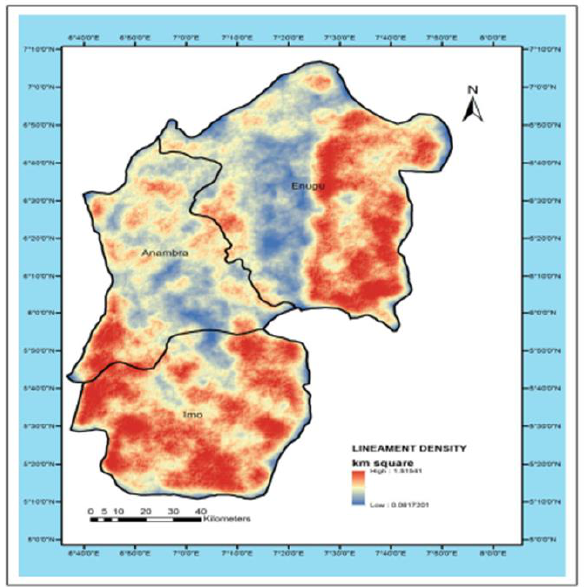
Figure 7: Lineament Density Map of the Study Area.